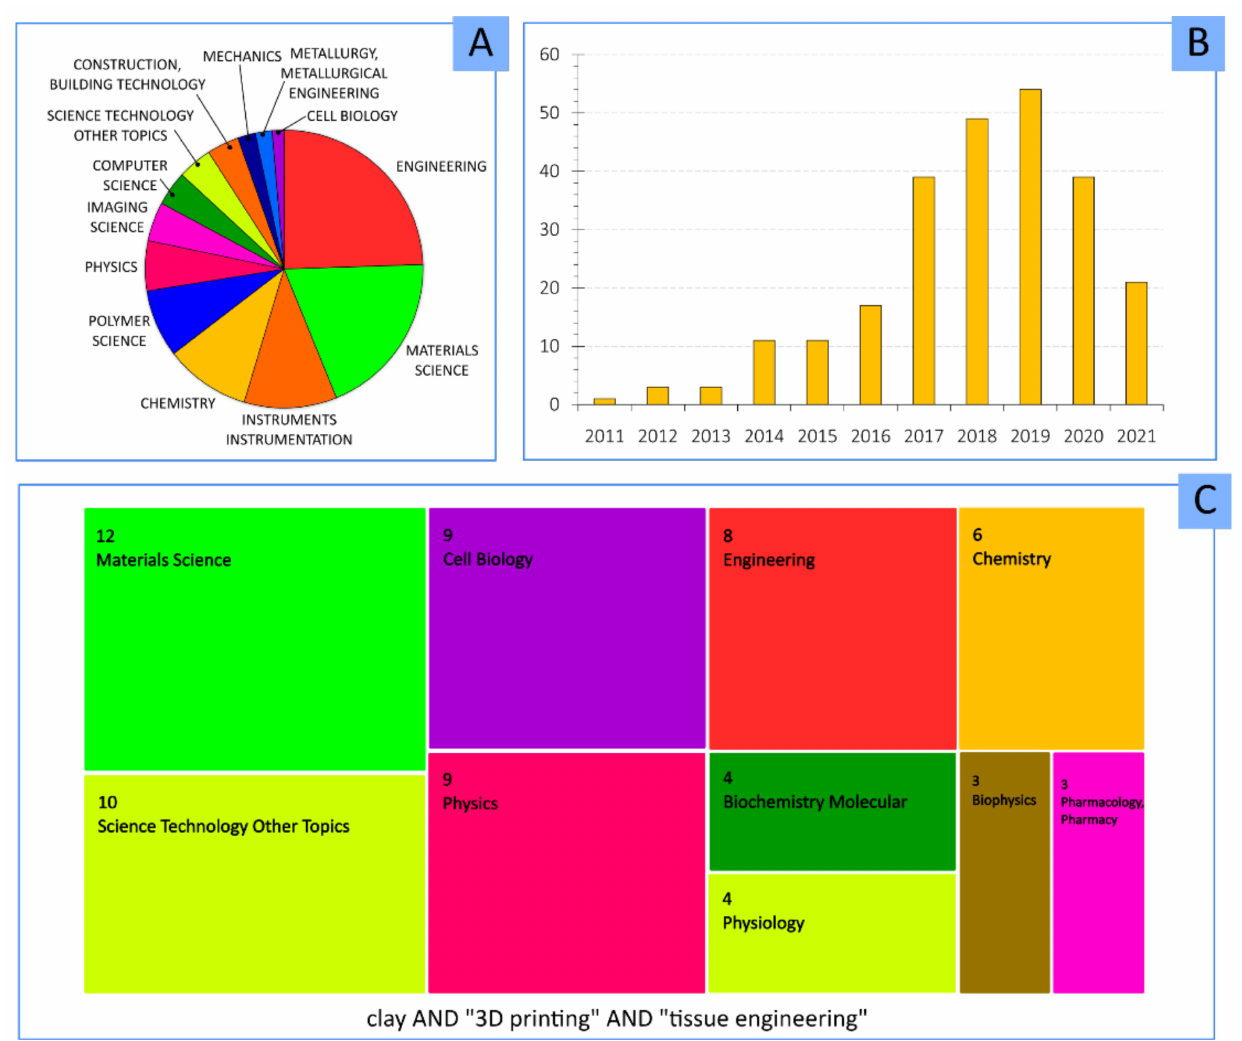
Figure 4. ( A ) Top 20 research areas with a higher amount of studies containing “clay” AND “3D printing”. ( B ) Number of publications per year containing “clay” AND “3D printing” keywords. ( C ) Main research areas for “clay” AND “3D printing” AND “tissue engineering”. Results obtained from database Web of Science. Current results in June